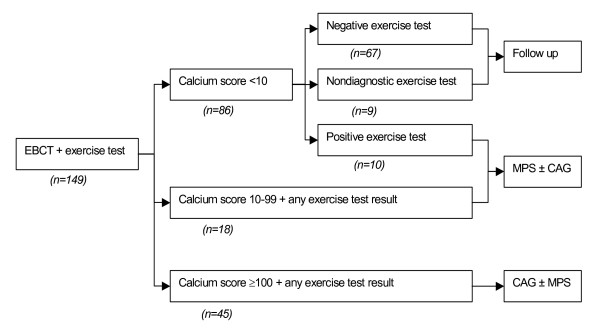
Decision protocol*. *see text for explanation. Abbreviations: CAG, coronary angiography; MPS, myocardial perfusion scintigraphy.